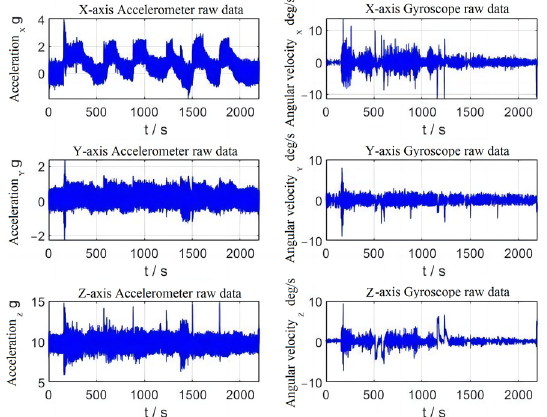
Figure 7. Flight test accelerometer and gyroscope data.